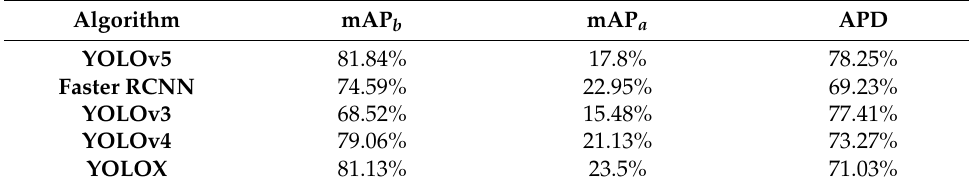
Table 4. Transferability testing results.